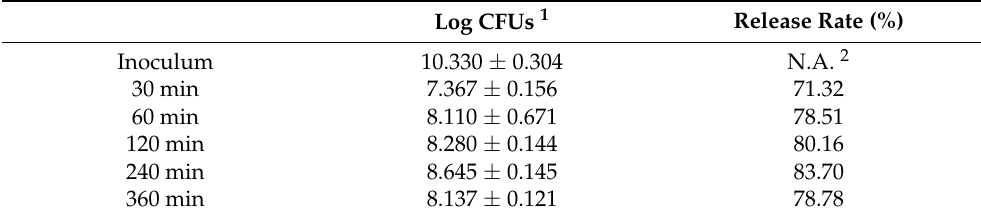
Table 4. Behavior of Microbiosys capsules in the simulated intestinal juice (pH